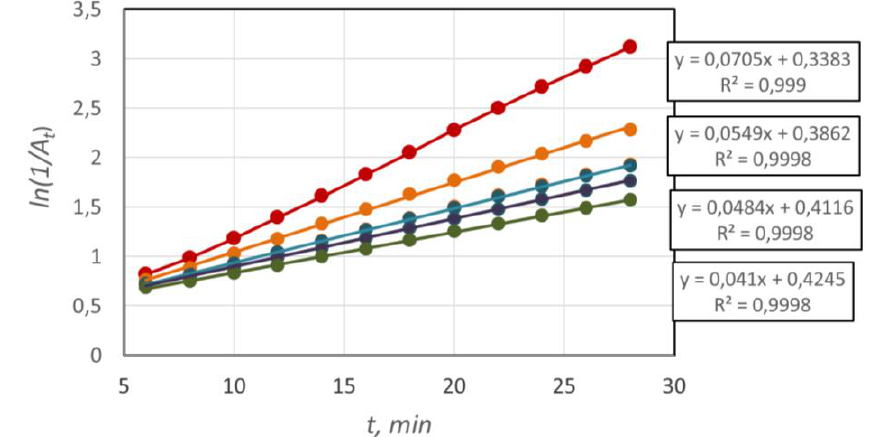
Figure 8. The linearization of the kinetic curves for the crocin bleaching with various Chardonnay wine supplements in the coordinates ln (1 / At) ÷